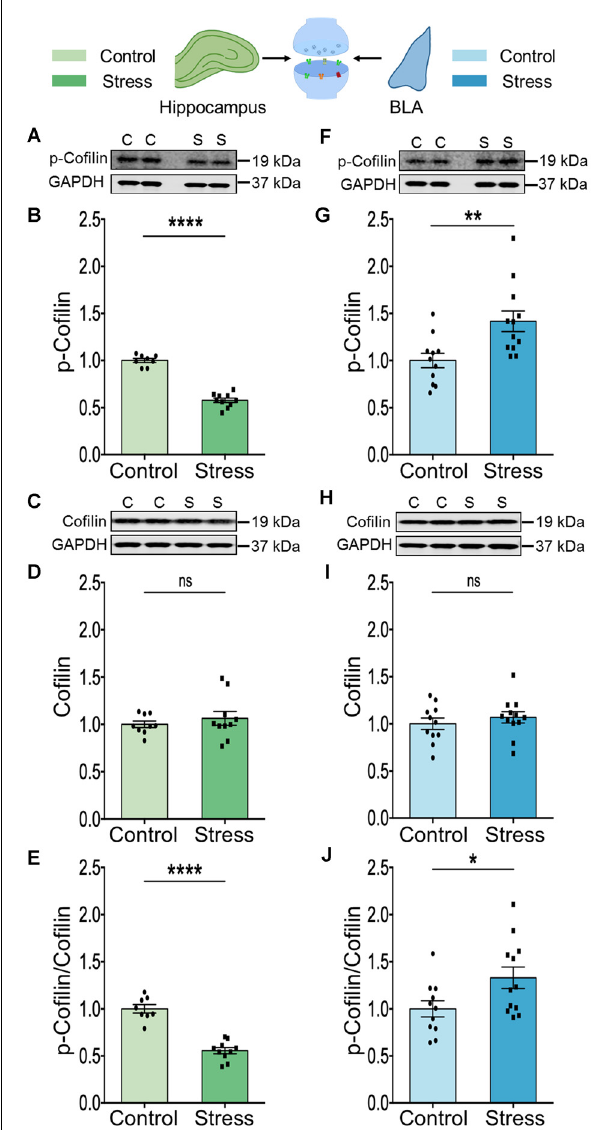
FIGURE 3 | Chronic stress modulates cofilin activity in a differential manner in the hippocampus and amygdala. (A,B) A significant decrease in the phosphorylation of the cofilin protein has been observed in the hippocampus of the stressed rats compared to the controls suggesting an increase in the activity of cofilin, as shown in the representative western blot (A) and the summary graph (B) . (C,D) The abundance of the cofilin protein has been observed to undergo no change in the hippocampus of stressed rats compared to controls as shown in the representative blot (C) and the summary graph (D) . (E) A significant decrease in the ratio of phospho-cofilin to total-cofilin has been observed in the hippocampus due to stress confirming an increase in cofilin activity. (F,G) A significant increase in the phosphorylation of cofilin protein has been observed in the amygdala of the stressed rats compared to the controls suggesting a decrease in cofilin activity as shown in the representative western blot (F) and the summary data (G) . (H,I) No detectable difference in the abundance of the cofilin protein has been noticed in the amygdala of stressed rats compared to controls as shown in the representative blot (H) and the summary graph (I) . (J) A significant increase in the ratio of phospho-cofilin to total-cofilin has